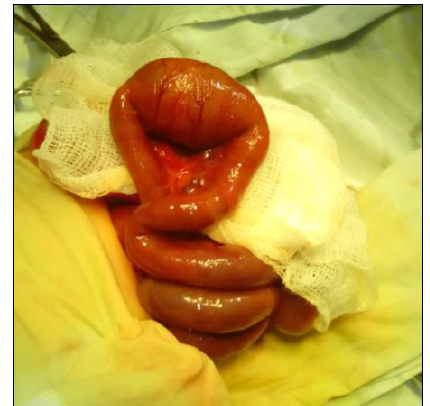
Figure 4: Segmental dilatation of the ileum in the third